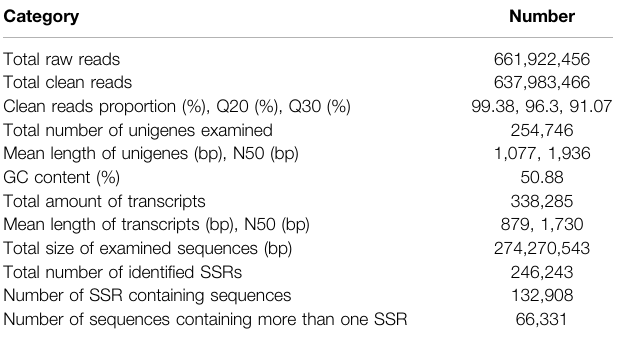
TABLE 2 | Summary statistics for transcriptome sequencing of P. trituberculatus